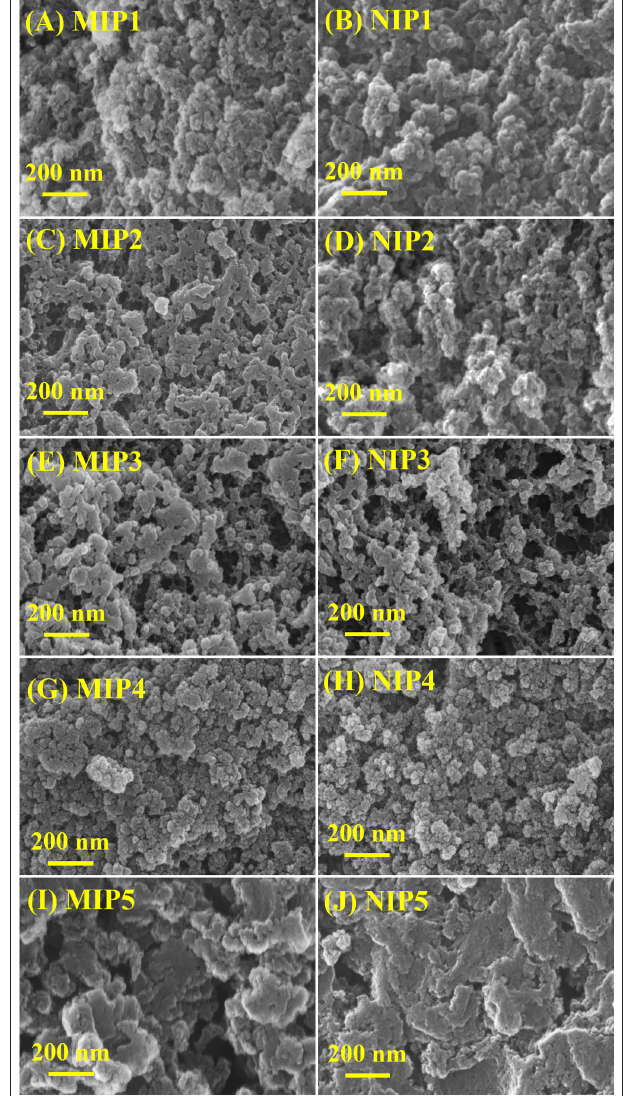
FIGURE 1 | SEM of (A) MIP1, (B) NIP1, (C) MIP2, (D) NIP2, (E) MIP3, (F) NIP3, (G) MIP4, (H) NIP4, (I) MIP5, and (J)